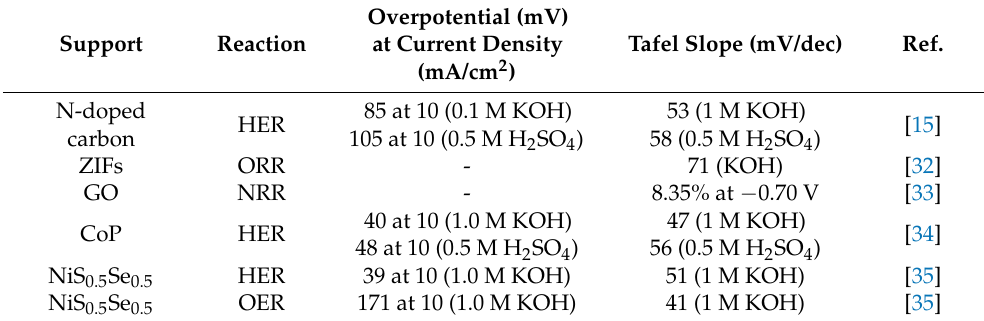
Table 1. Electrochemical parameter of single tungsten atom catalysts currently